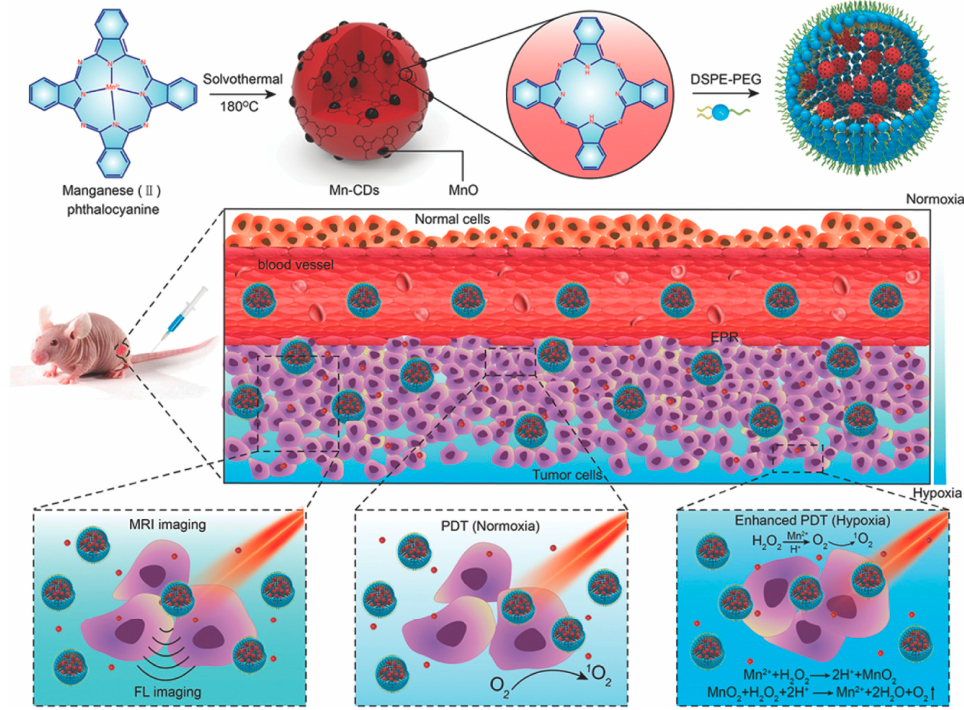
Figure 6. Schematic illustration of the Mn-CD assembly as an acidic H 2 O 2 -driven oxygenator to enhance the anticancer efficiency of PDT in a solid tumor [48]. Copyright 2018, Wiley.